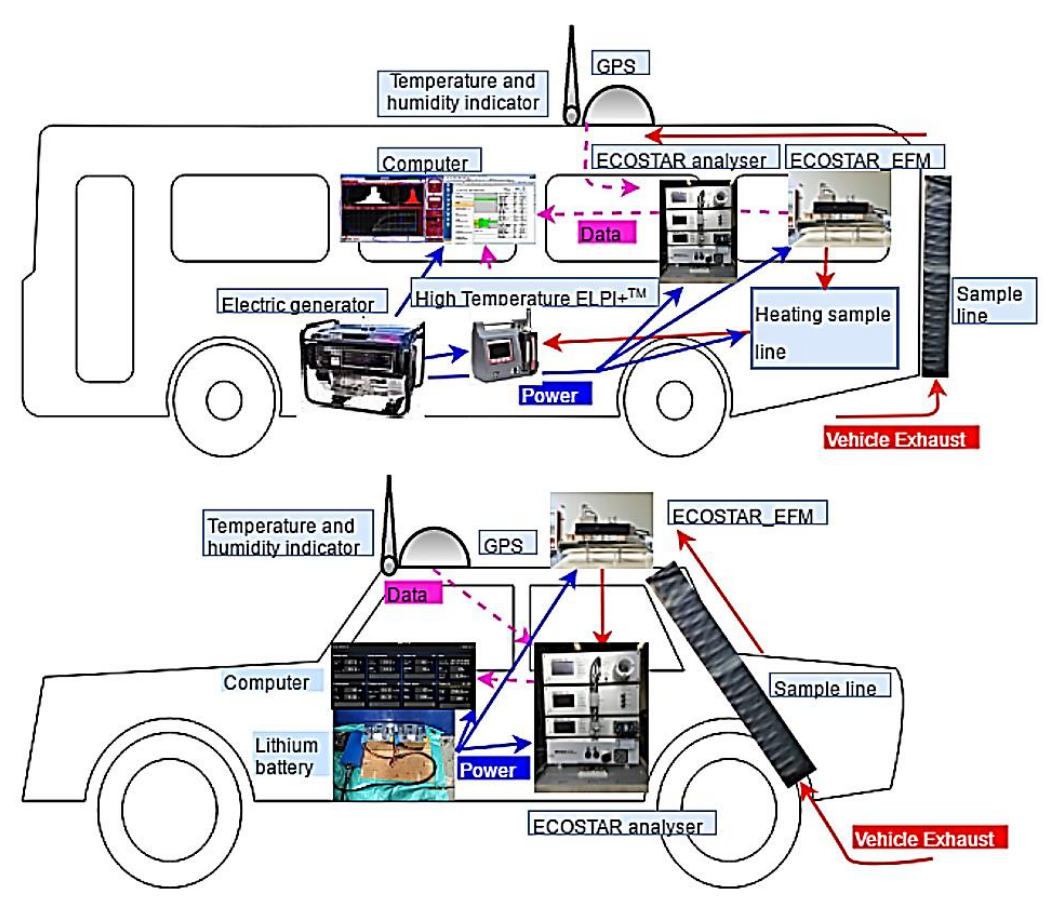
Figure 1. The layout diagram of the PEMS equipment in vehicle tests.